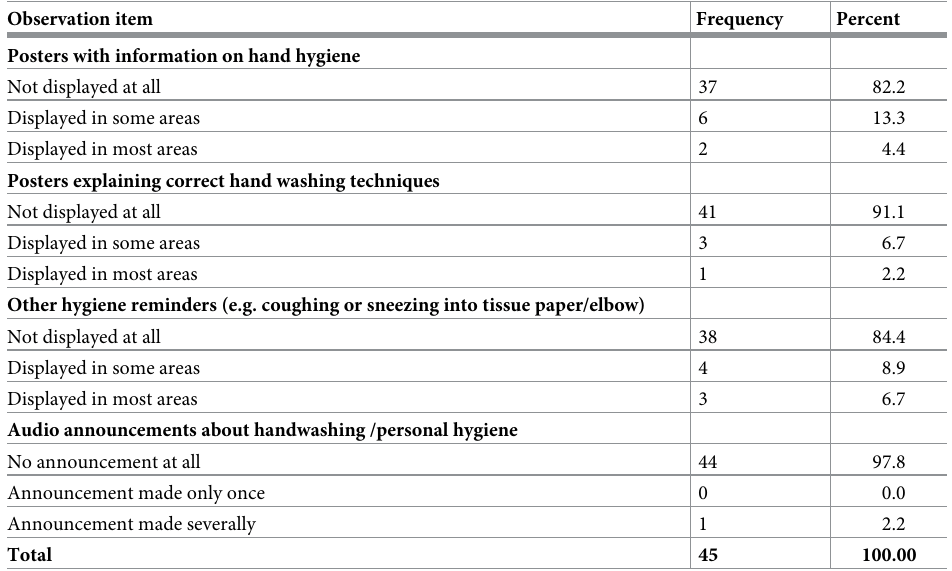
Table 2. Hand hygiene communication at selected transport stations in the Greater Accra Region (n = 45).